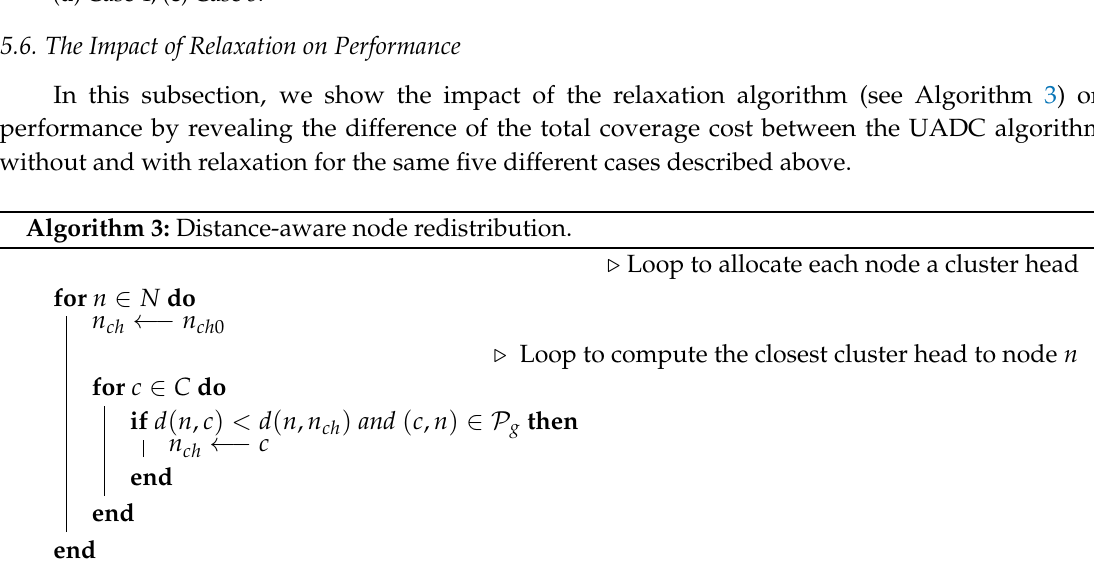
Figure 15. Algorithms difference based on different topologies. ( a ) Case 1; ( b ) Case 2; ( c ) Case 3; ( d ) Case 4; ( e ) Case 5.